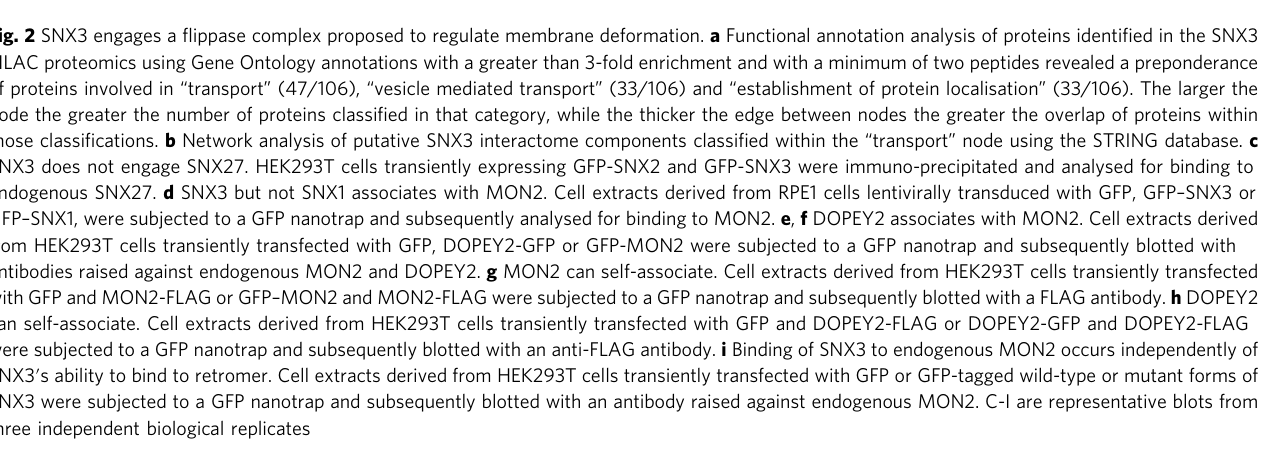
Fig. 2 SNX3 engages a fl ippase complex proposed to regulate membrane deformation. a Functional annotation analysis of proteins identi fi ed in the SNX3 SILAC proteomics using Gene Ontology annotations with a greater than 3-fold enrichment and with a minimum of two peptides revealed a preponderance of proteins involved in “ transport ” (47/106), “ vesicle mediated transport ” (33/106) and “ establishment of protein localisation ” (33/106). The larger the node the greater the number of proteins classi fi ed in that category, while the thicker the edge between nodes the greater the overlap of proteins within those classi fi cations. b Network analysis of putative SNX3 interactome components classi fi ed within the “ transport ” node using the STRING database. c SNX3 does not engage SNX27. HEK293T cells transiently expressing GFP-SNX2 and GFP-SNX3 were immuno-precipitated and analysed for binding to endogenous SNX27. d SNX3 but not SNX1 associates with MON2. Cell extracts derived from RPE1 cells lentivirally transduced with GFP, GFP – SNX3 or